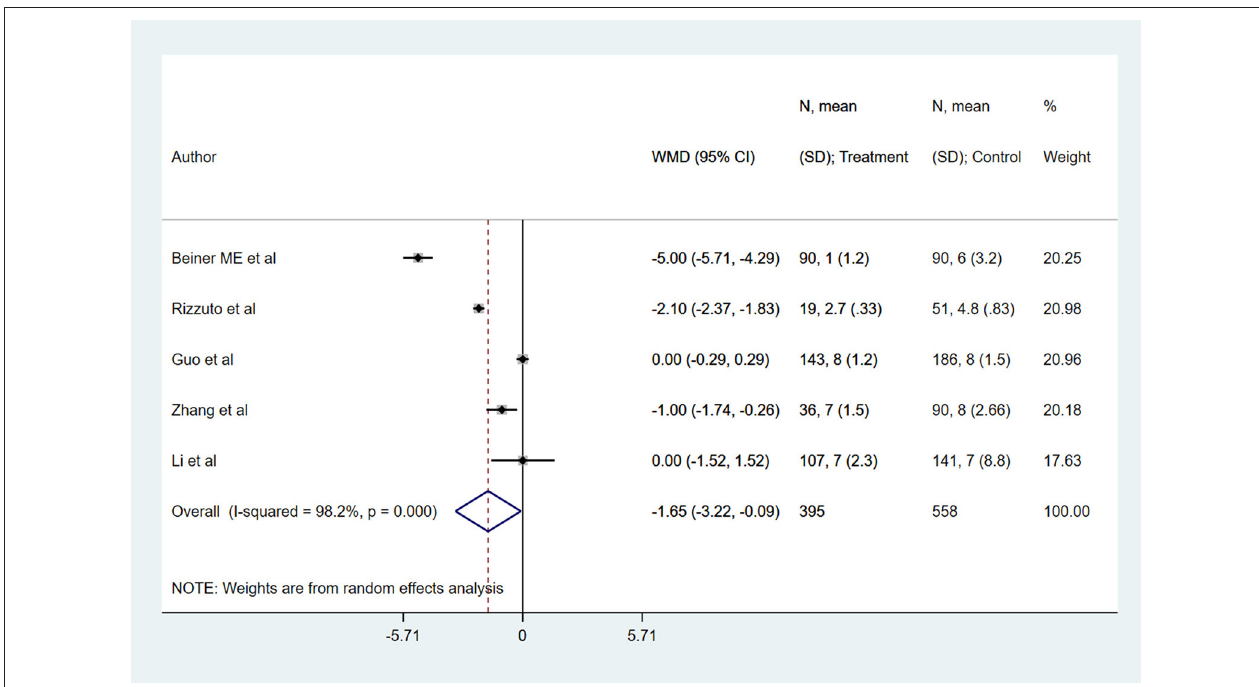
FIGURE 6 | The pooled effect size for the length of post-operative hospital stay (in days) based on the comparison between radical trachelectomy and hysterectomy in patients with early-stage cervical cancer.